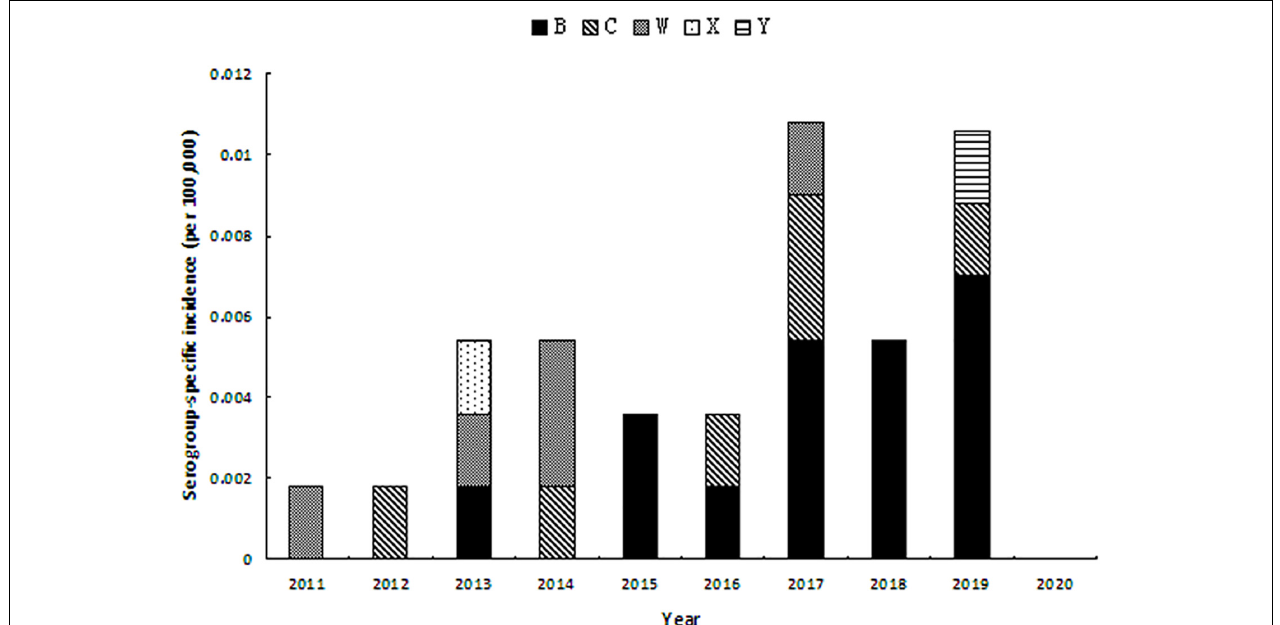
that the distribution of serogroups showed high homogeneity in healthy population, 12 samples (70.59%) were MenB, and 1 sample (5.88%) each for MenC and MenY. MenB was